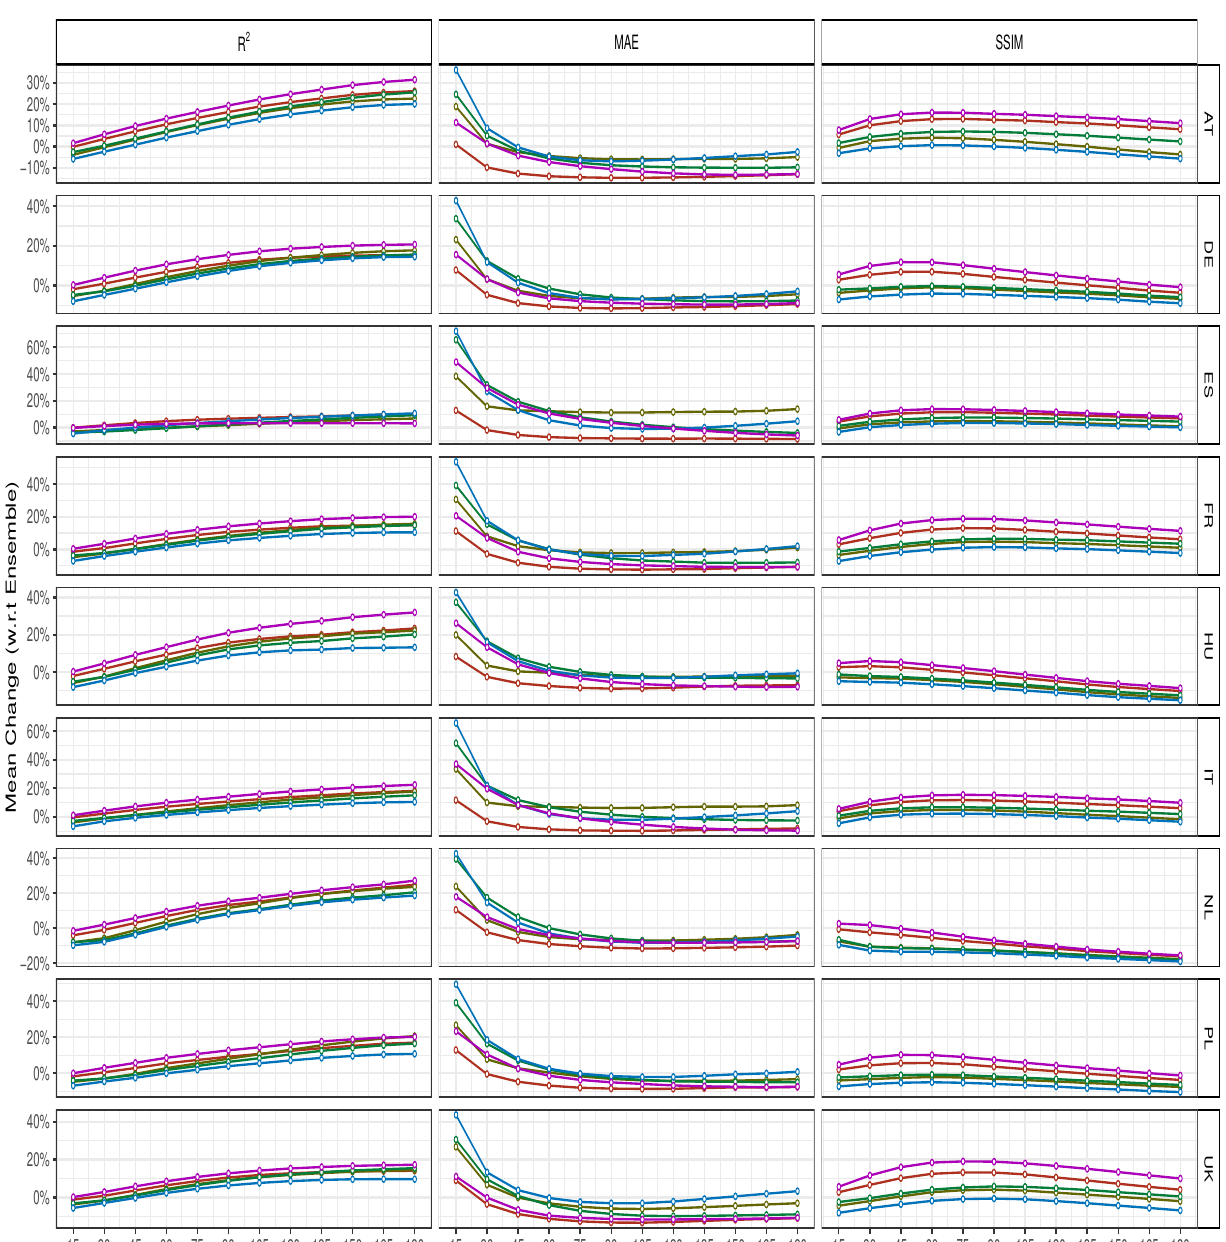
Figure 6. Regional differences in cumulative mean accuracy metrics for all lead times across all ConvGRU based models. Results show the mean percentage change with respect to the optical flow ensemble model for each time